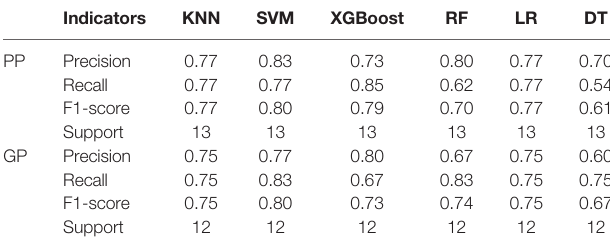
TABLE 7 | The results of four indicators — precision, recall, F1-score, and support in validation set.